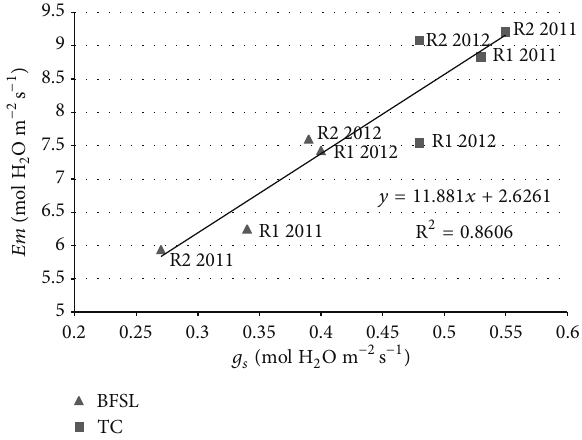
Figure 2: Regression of mean Em to 𝑔 𝑠 at growth stages R1 and R2 of 10 maize hybrids grown under furrow irrigation on a Bosket fine sandy loam (BFSL) and a Tunic clay (TC) soil near Stoneville, MS, in 2011 and 2012. Each data point represents the mean of 10 hybrids, 3 plants, and 4 replications at one growth stage and one site per year.